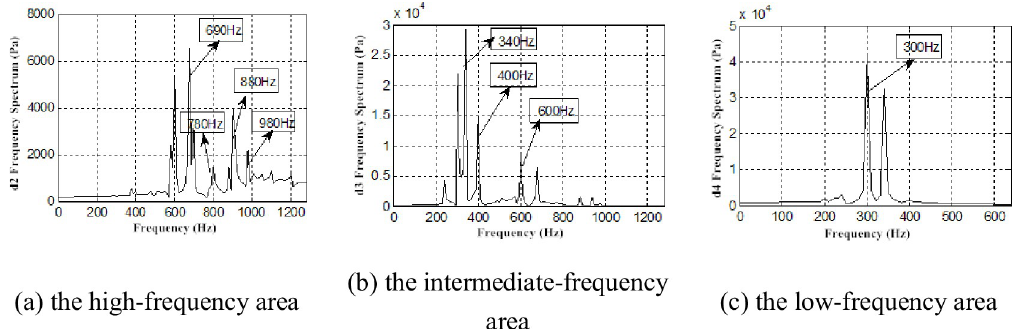
Fig 10. Frequency spectrum of interstage pressure pulsation restructuring signal under F =